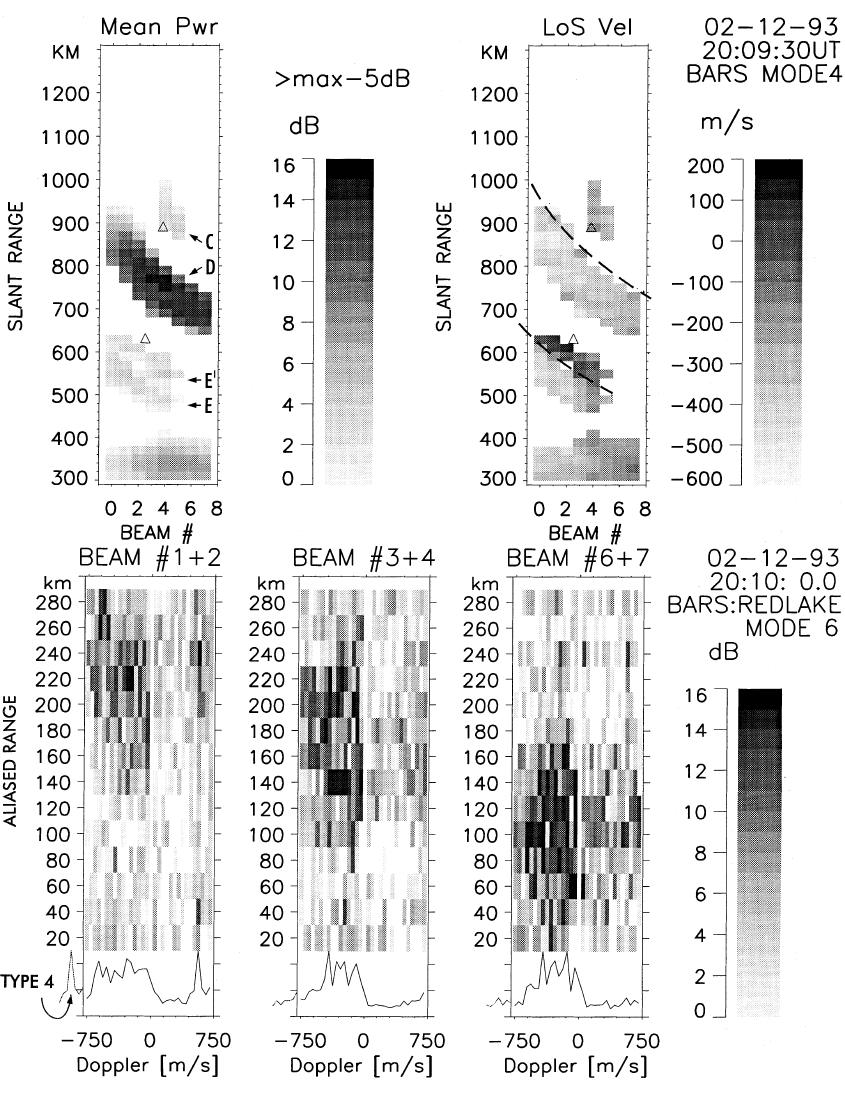
Fig. 9. BARS Red Lake radar maps of the mean backscatter power and line-of- sight velocities for the Red Lake ( top panels ). Location of GILL and FCHU CANOPUS sites are shown and the individual bands are labeled. Broken lines represent likely positions of auroral arcs indicated by riometer absorption observed when the structures moved overhead in GILL. BARS spectra ( bottom panels ; add 600 km to the aliased range to obtain the true slant range) near the cusp (band D ). Both the frequency and range aliasing can be resolved by examining the mean power and Doppler obtained 30 s earlier ( top